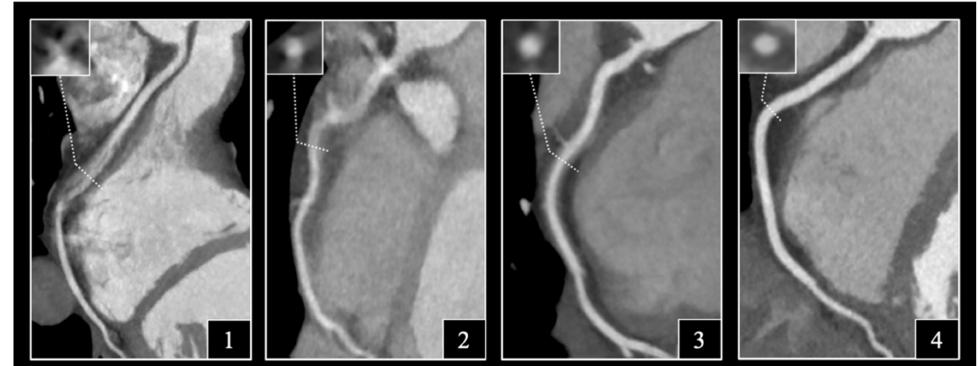
Figure 2. Representative curved multiplanar reconstructions and corresponding cross-sectional images demonstrating examples of the 4-point Likert scale describing motion artifacts: (1), non- diagnostic image quality precluding the evaluation of the right coronary artery; (2), moderate image quality merely allowing the exclusion of obstructive stenosis; (3), good image quality with minor artifacts and (4), excellent image quality with no artifacts present.